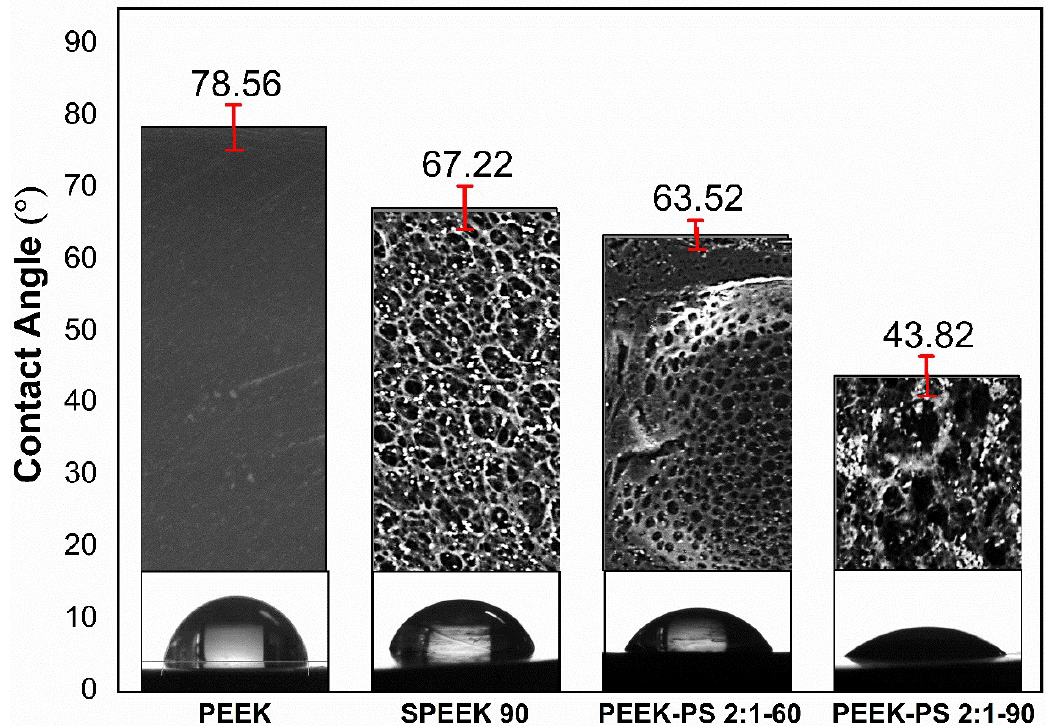
Figure 11. Surface contact angle measurements through the contact angle of the water on untreated PEEK, SPEEK 90, and piranha-solution-treated PEEK-PS 2:1-60 and PEEK-PS 2:1-90 obtained from SEM micrographs using Gwyddion software. Results are presented as means ± SD ( n = 5). p -value > 0.05.